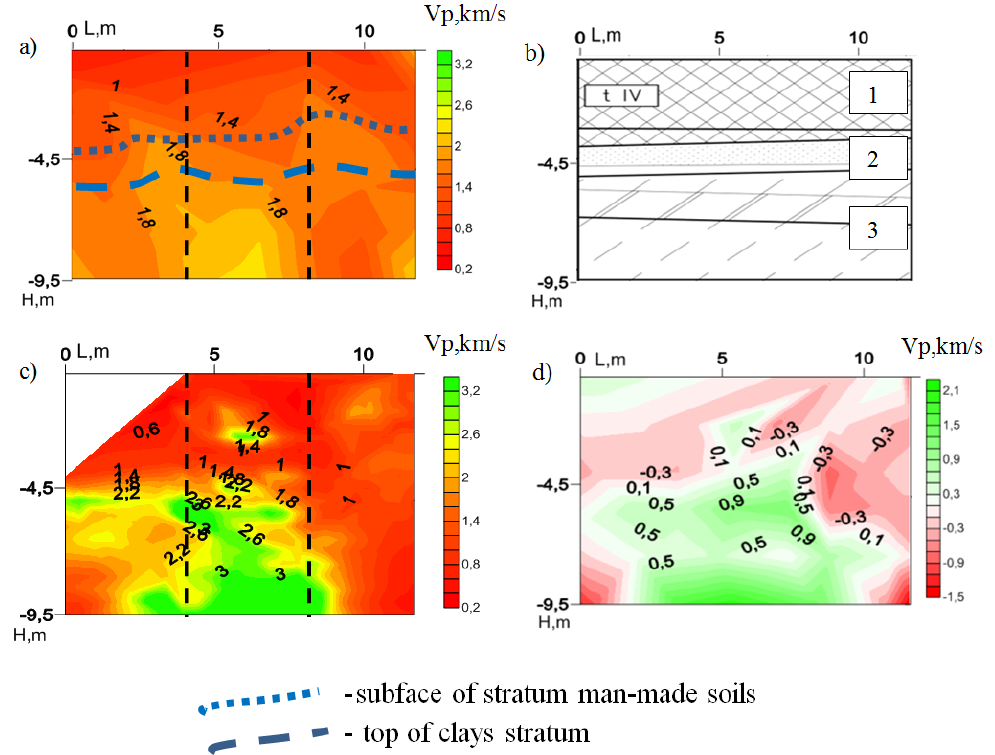
Figure 4. Results of seismic tomography: ( a ) before stabilization rock; ( b ) after stabilization rock; ( c ) log of hole; ( d ) analysis by velocity differences.